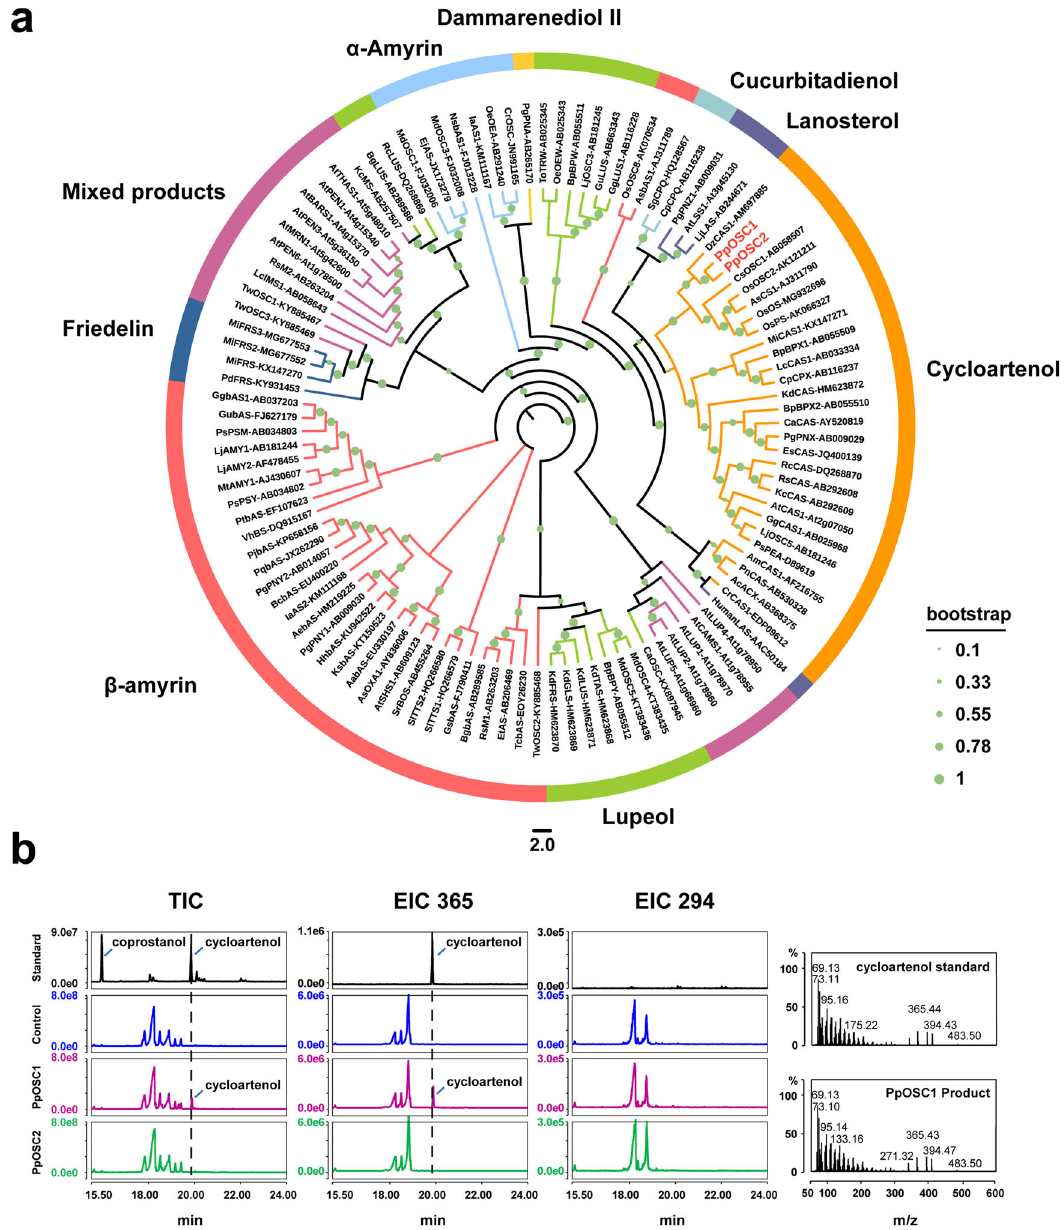
Fig. 2 Candidate OSC genes and gene function veri fi cation. a Phylogenetic tree of OSCs. Predicted amino acid sequences of OSCs in P. polyphylla var. yunnanensis were aligned with selected OSCs from other plant species using MUSCLE. The evolutionary history was inferred using the maximum-likelihood method. The bootstrap consensus tree inferred from 1000 replicates is taken to represent the evolutionary history of the taxa analyzed. b Functional veri fi cation of PpOSC gene. Two OSC genes were identi fi ed in P. polyphylla var . yunnanensis , and the results of GC-MS showed that PpOSC1 gene increased the yield of cycloartenol after being transferred to N. benthamiana